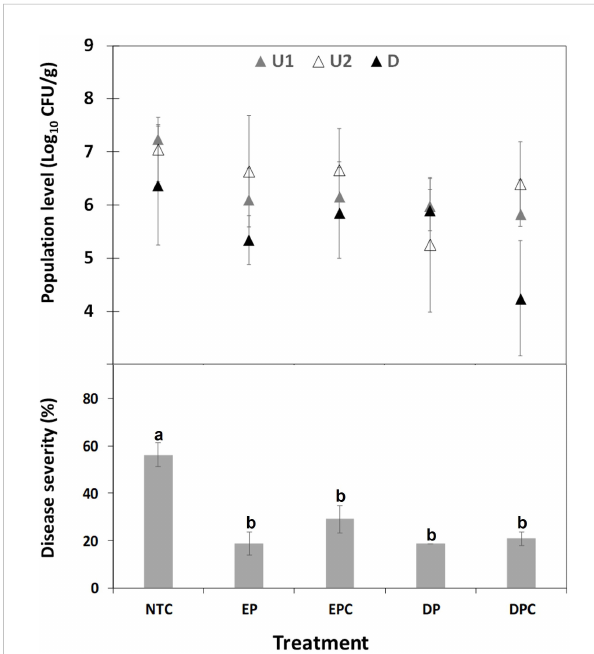
FIGURE 5 Effect of EGL2 treatment strategies on X. fastidiosa subsp. fastidiosa IVIA 5387.2 population levels in almond plants after 70 days post inoculation. Four independent strategies of EGL2 treatment (60 µl/ml) were used and consisted of: (1) preventive application by endotherapy 1 day before the pathogen inoculation (1dbi, EP); (2) combination of preventive (1 dbi) and curative application by endotherapy 7 and 43 days post-inoculation (dpi, EPC); (3) preventive application (1 dbi, DP) by soil drench, and (4) combination of preventive (1 dbi) and curative application by soil drench 7 and 43 dpi (DPC). Sampled zones are also indicated as upwards zones (U1 and U2) and downwards zone (D), in relation to the point of inoculation and product injection. Values are the means of 6 plants, and error bars represent the standard deviation of the mean. The effect of treatments was signi fi cant according to ANOVA (p<0.0001). Different letters between treatments indicate signi fi cant differences between disease severities according to Tukey ’ s test (P ≤